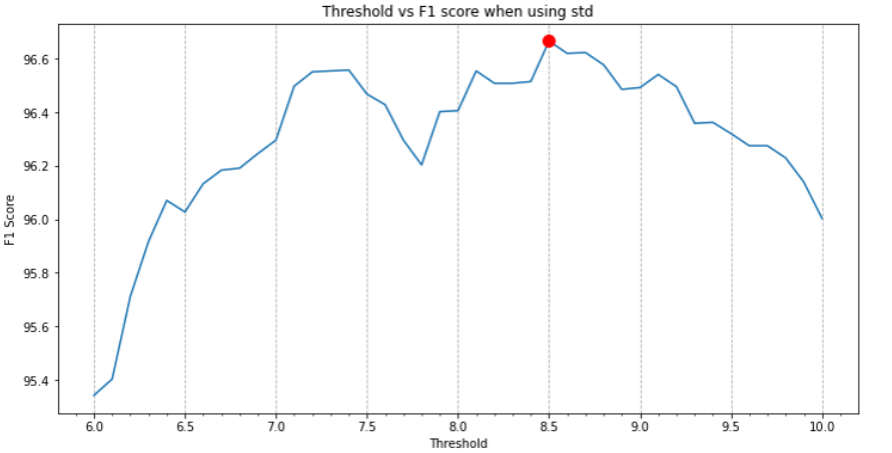
Figure 15. F1 scores for different standard deviation thresholds when classifying high- and low- activity windows. The red dot indicates the chosen